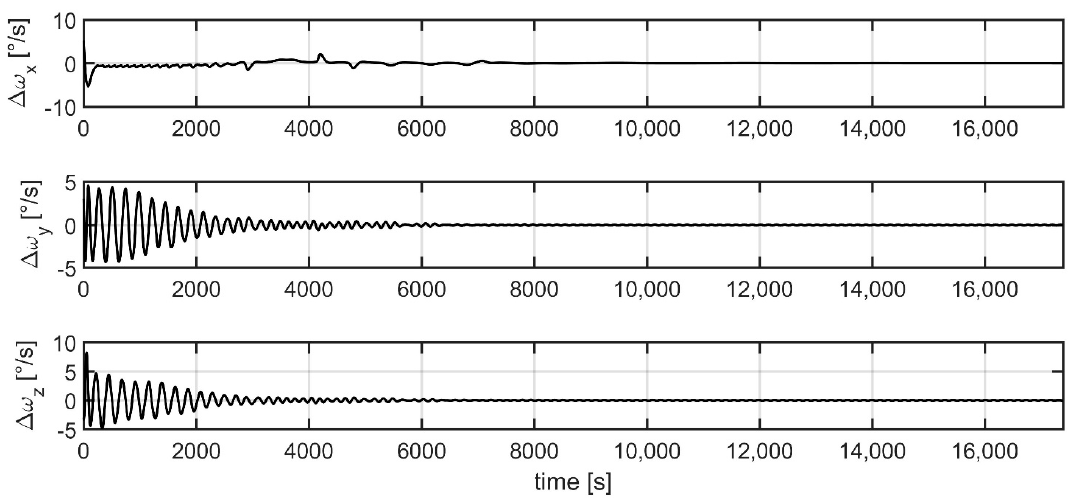
13 of 21 Table 5. Root Mean Square of attitude estimation errors for Test Case 2.